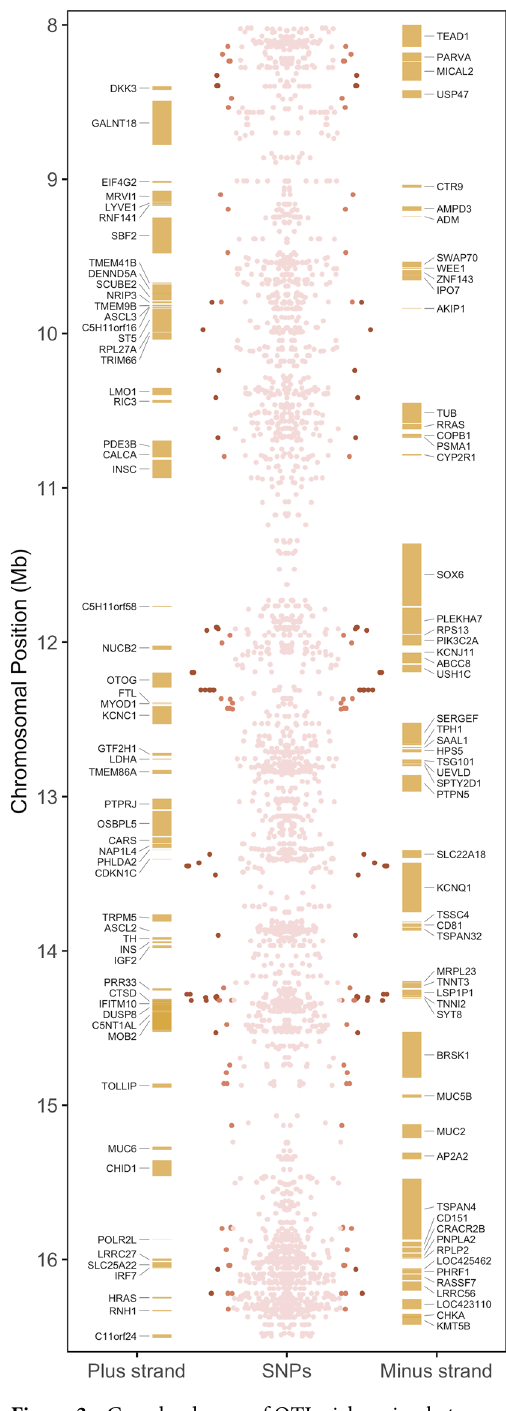
Figure 3. Gene landscape of QTL-rich region between 8.0 Mb and 16.5 Mb on chicken chromosome 5. Mirrored Manhattan plot shows SNPs with significance thresholds indicated by color; dark red = significant, orange =